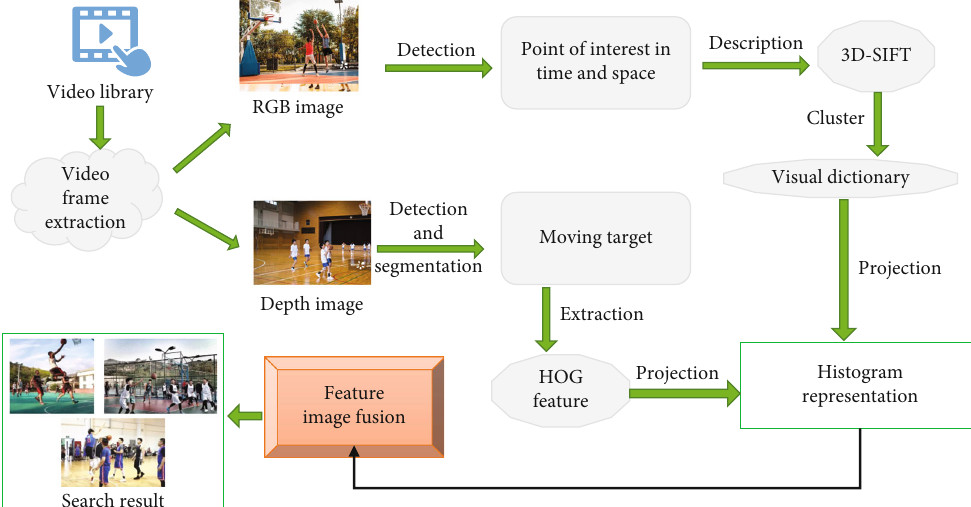
Figure 1: Algorithm structure block